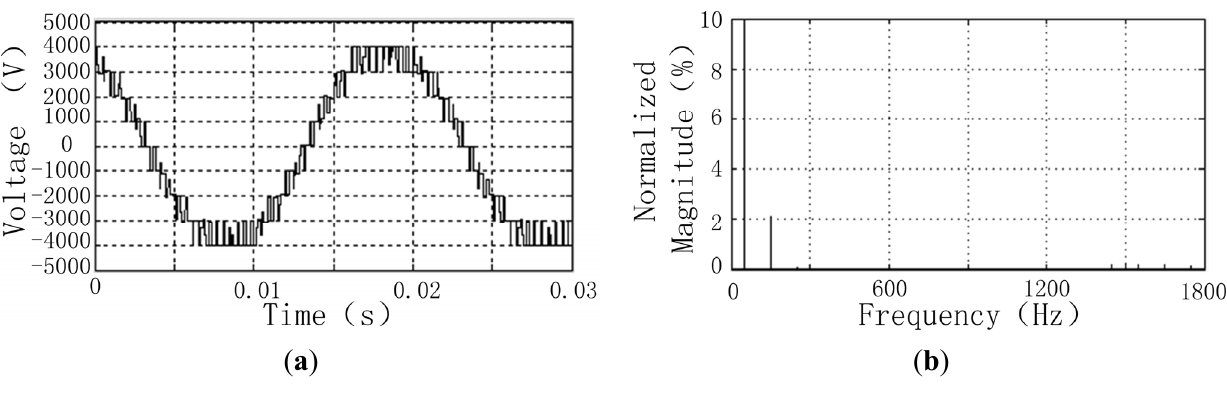
Figure 5. Result of the proposed PSCPWM when the second cell dc voltage is 395 V: ( a ) output voltage waveform; and ( b )